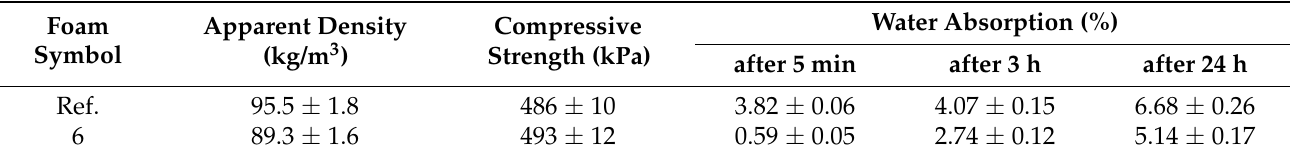
Table 4. The results of physico-mechanical properties of